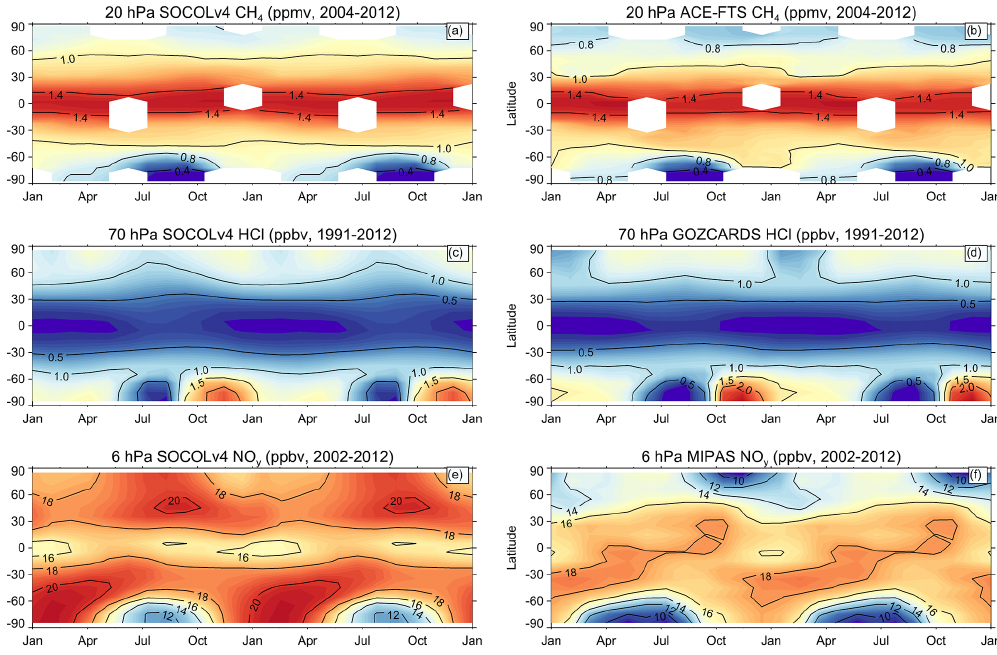
Figure 9. CH 4 , HCl, and NO y zonal mean seasonal cycles at 20, 70, and 6hPa, respectively. First column: SOCOLv4 data. Second column: ACE-FTS, GOZCARDS, and MIPAS observational data. Two consecutive cycles are shown.